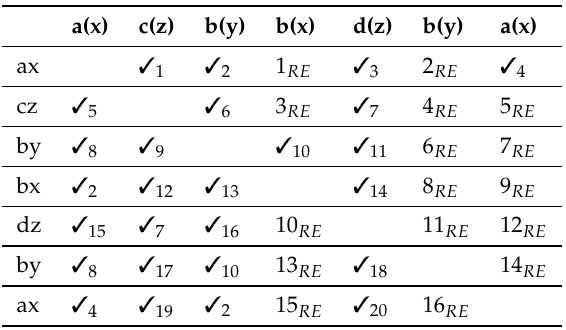
Table 18. MR-I results for coExistence constraints (activation).